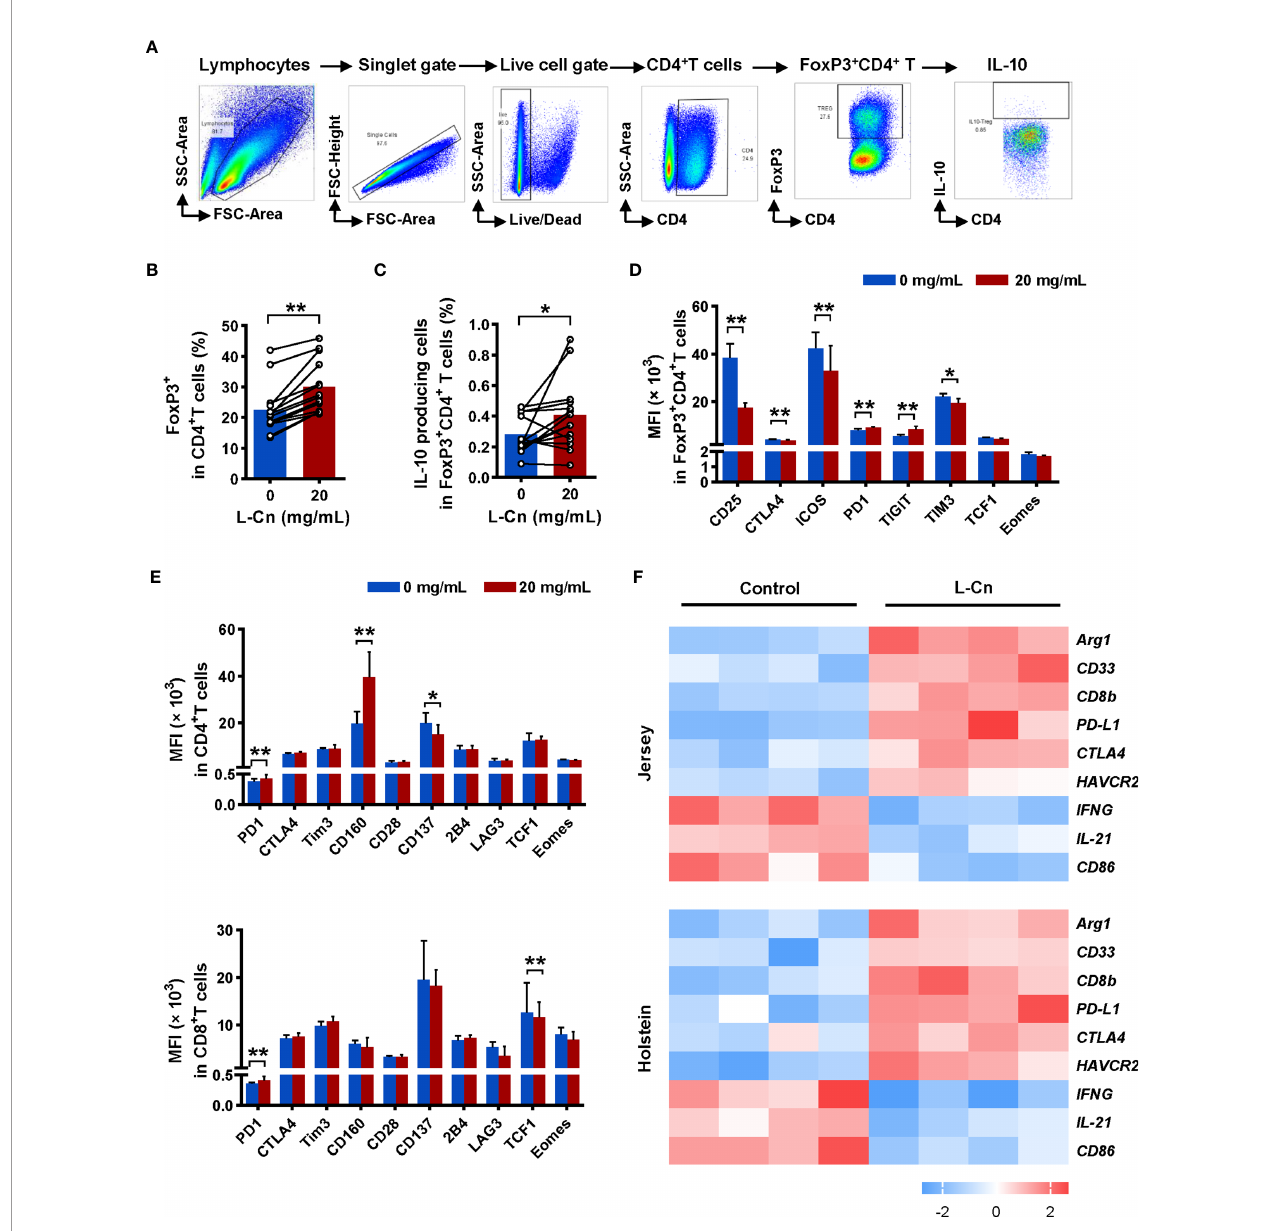
FIGURE 4 | L-Cn up-regulates inhibitory receptors on T cells and enhances IL-10-producing Treg cells. (A) Gating strategy for FoxP3 + CD4 + T cells. (B, C) The frequencies change and function of FoxP3 + CD4 + regulatory T (Treg) cells after L-Cn stimulation. (D, E) The mean fl uorescence intensity (MFI) of indicated activated and inhibitory receptors on T-cell subsets after L-Cn stimulation. (F) Heat map illustrating the relative expression of the indicated genes according to a GEO microarray dataset (GSE62595). (B – E) Wilcoxon signed-rank test. * P < 0.05, ** P < 0.01. L-Cn,